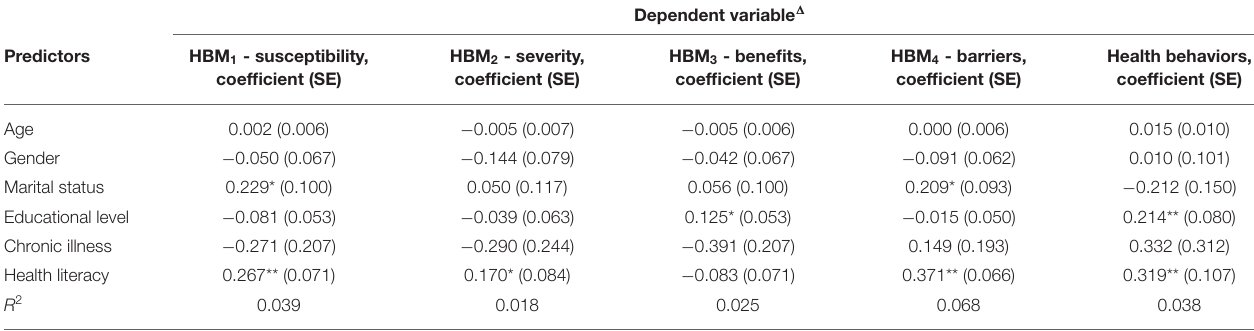
TABLE 4 | Linear regression predicting health beliefs and health behaviors.